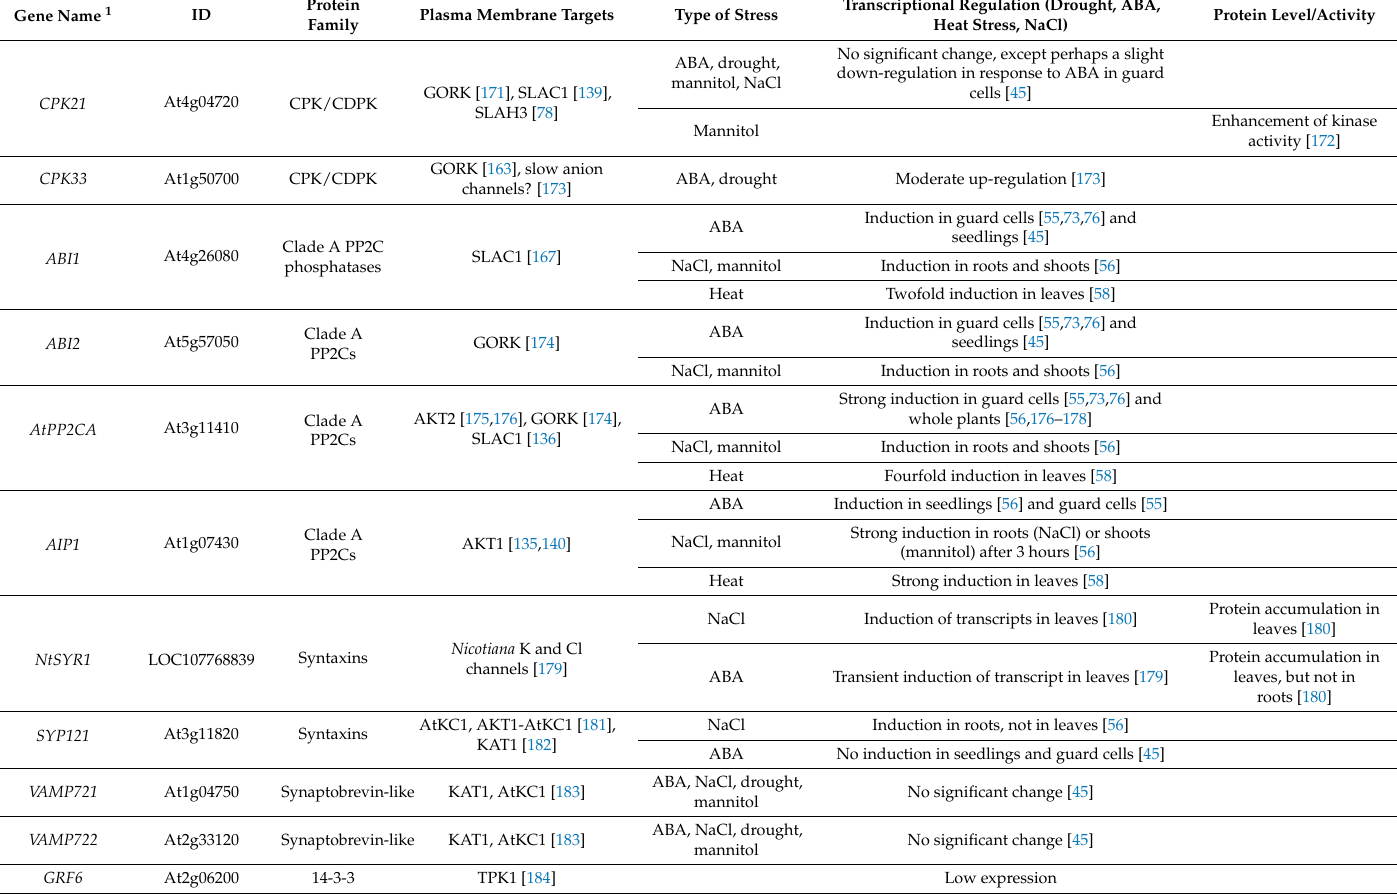
VAMP: vesicle-associated membrane protein. All genes originate from Arabidopsis thaliana except NtSYR1 (from Nicotiana tabacum